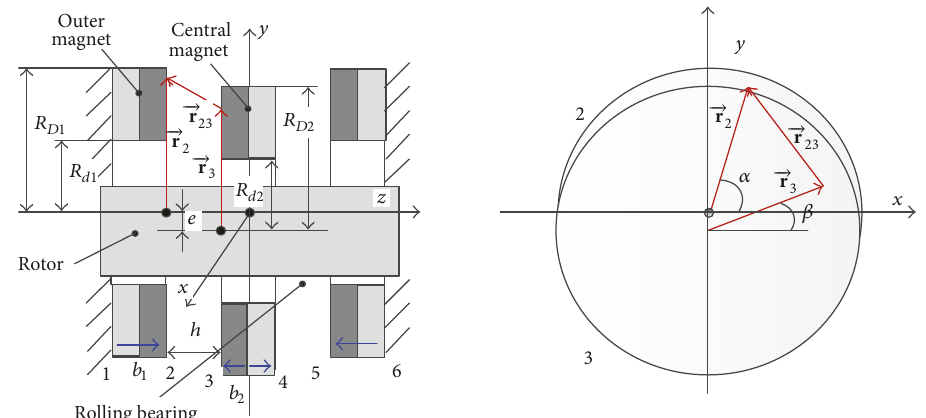
Figure 1: Structure of the magnetic spring.